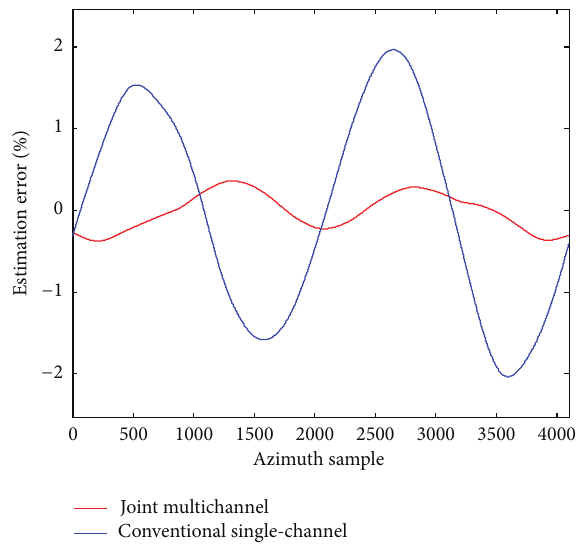
Figure 5: Comparison of the center APC Doppler rate estimation accuracy between the proposed method and the conventional